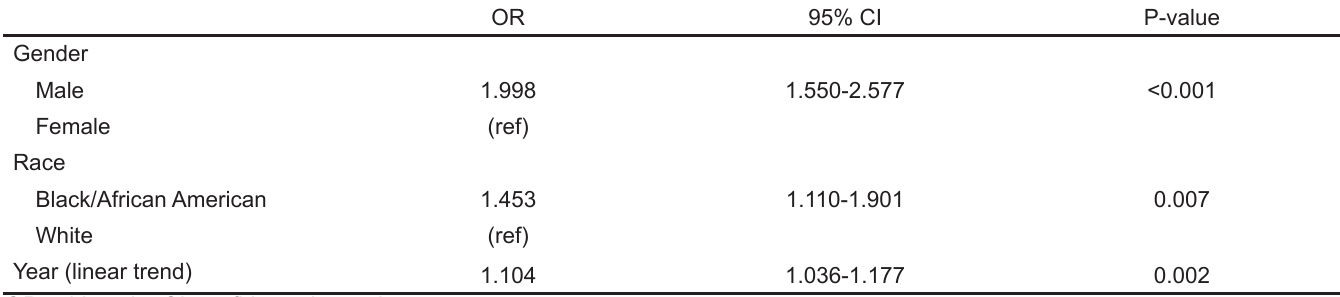
Table 2. Associations of urine drug screen use in all ED patients using multivariable logistic regression.